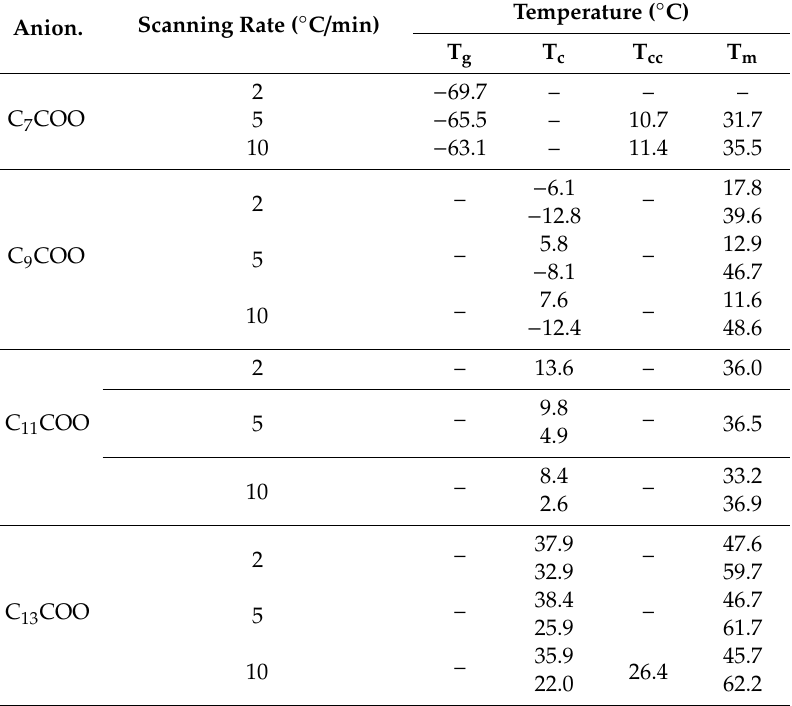
Table 1. Glass transition (T g ), crystallization (T c ), cold crystallization (T cc ), and melting (T m ) temperatures for FA-PILs with HTMG cation.